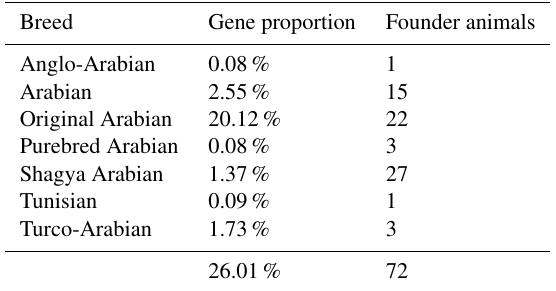
Table 1. The proportion of genetic contribution of Arabian founders in the Lipizzan population of the Austrian federal stud farm of Piber. Breed Gene proportion Founder